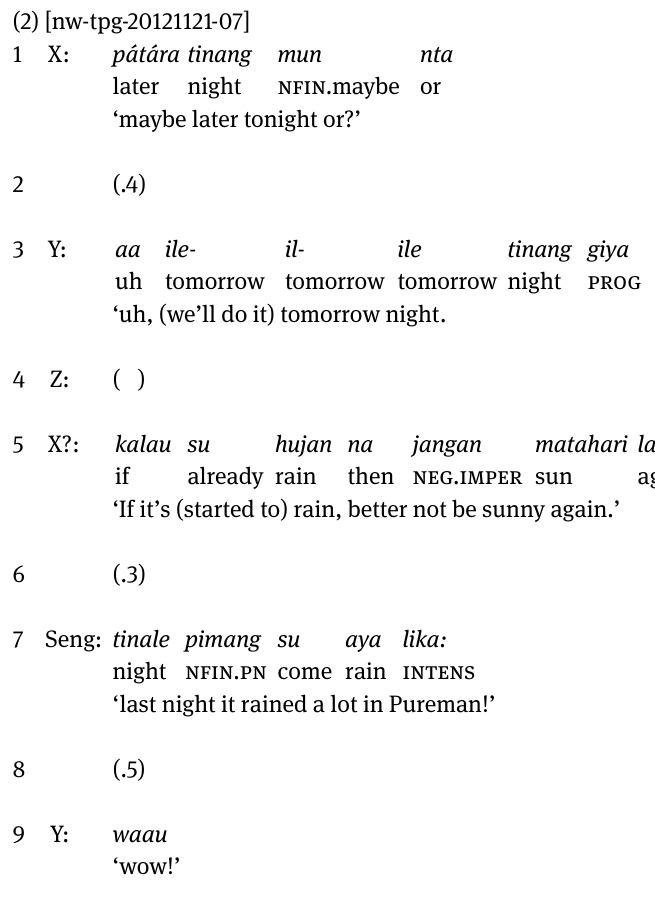
Figure 3. Burning fields at the end of the dry season Another nearby area has just been mentioned in immediately prior talk when at line 1 speaker X (far left) produces a question directed at speaker Y (middle) about when he plans to burn the other field (this was recorded at Y’s home). Speaker Y responds that he plans to burn that field tomorrow night, to which speaker X responds with a sort of invocation. In line 7, Seng informs them that it has already started raining in a nearby village, using the place name Pimang